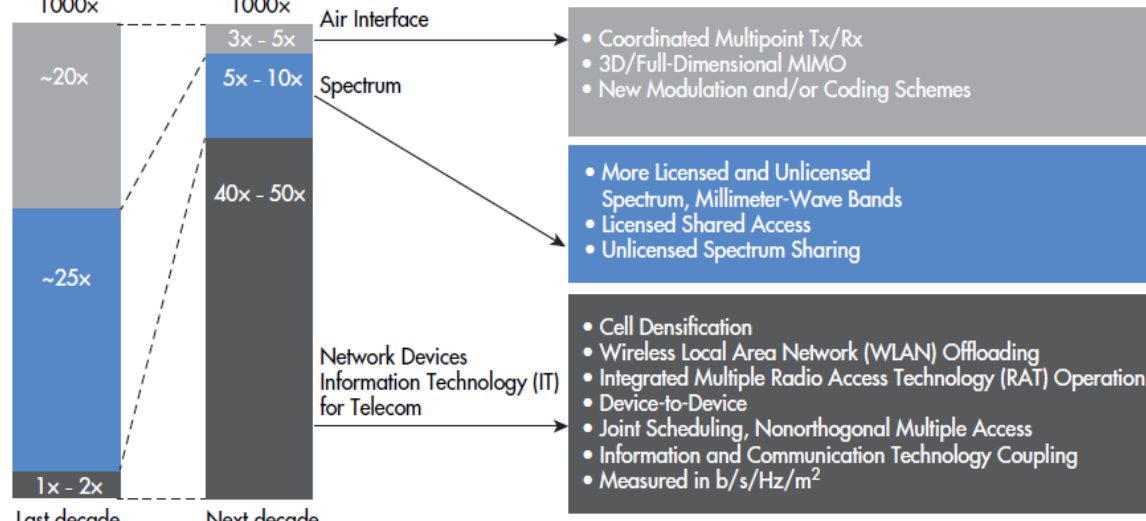
Figure 2 The need for bandwidth to transfer large amounts of data through wireless channels makes the use of millimeter-wave frequencies in 5G wireless networks inevitable. (Graphic courtesy of National